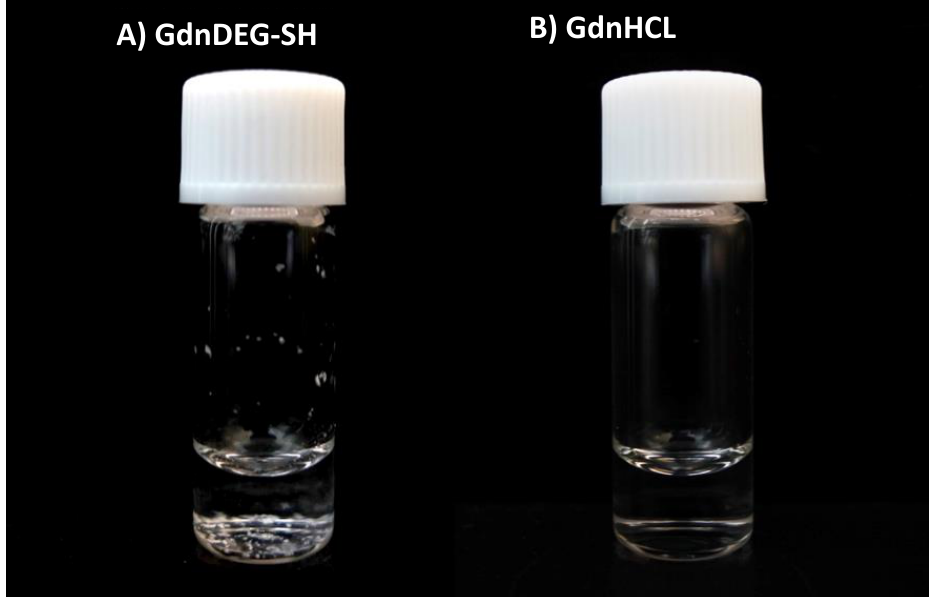
Figure 5. A photograph of a glass bottle containing lysozyme (20 µ M) in the presence of ( A ) GdnDEG- SH (1.0 mM) and ( B ) guanidine hydrochloride (GdnHCl, 0.50 M) in a buffer (50 mM Tris-HCl, 300 mM NaCl, pH 7.5) after cooling from 96 to 25 ◦ C. In ( A ), white precipitates are observed at the bottom of the glass